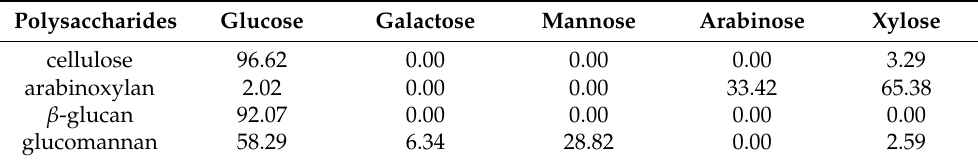
Table 1. Monosaccharide composition of cellulose, β -glucan, arabinoxylan and glucomannan (mol %).